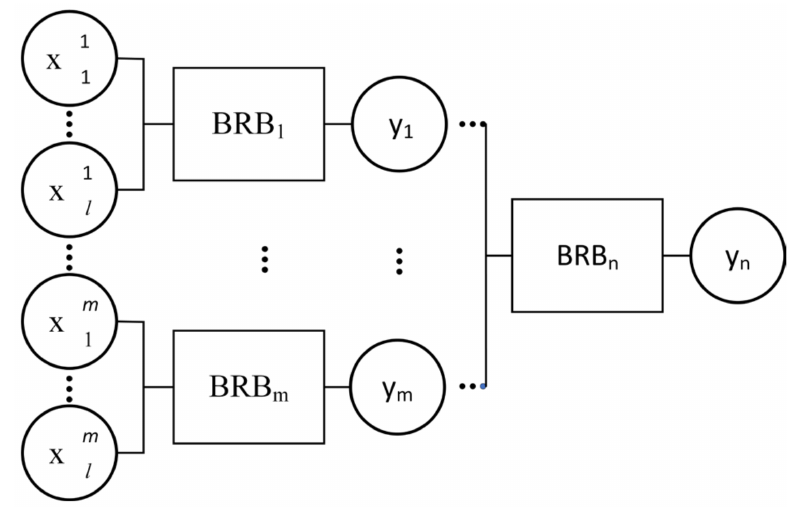
Figure 2. The basic structure of the multi-layer BRB model.